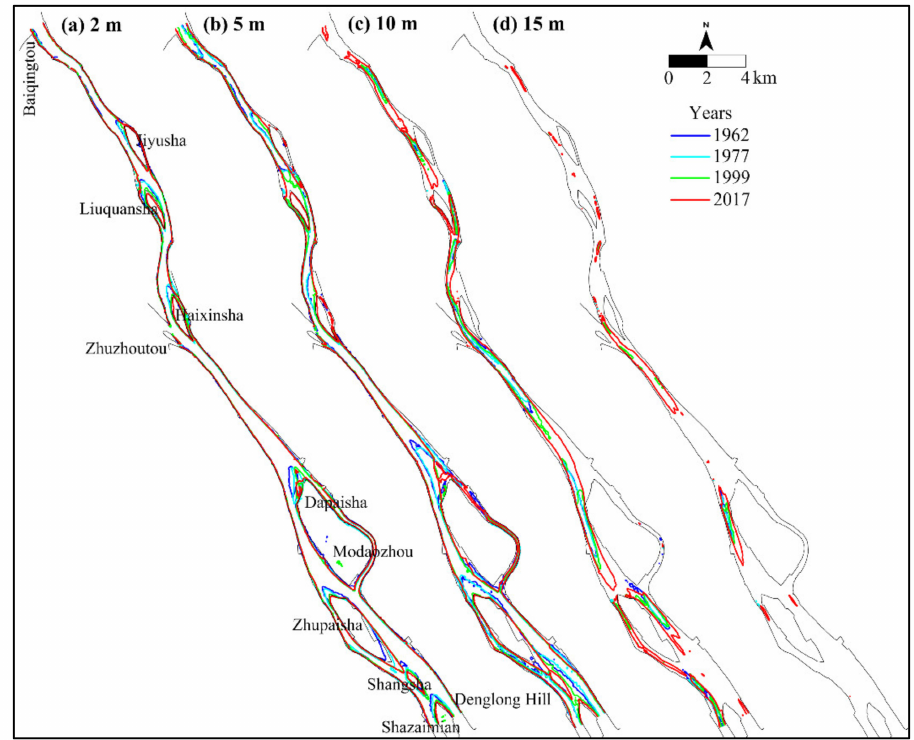
Figure 3. Planar changes in the ( a ) 2 m, ( b ) 5 m, ( c ) 10 m, and ( d ) 15 m isobaths from 1962 to 2017.